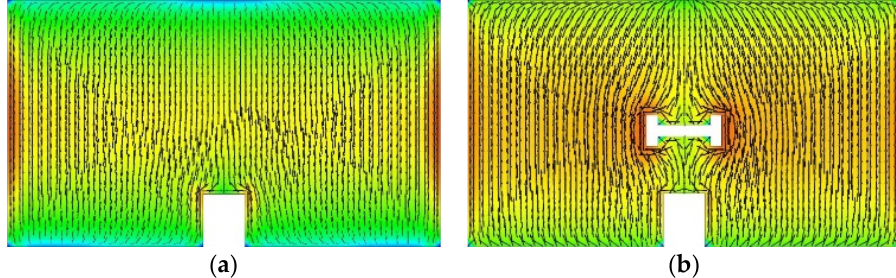
Figure 8. Current distribution of the TM01 mode. ( a ) Conventional patch antenna. ( b ) Proposed H-slot antenna.